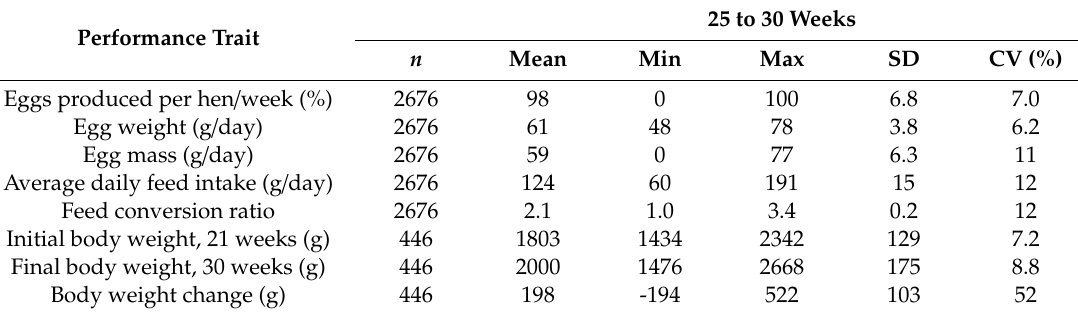
Table 1. Descriptive statistics of hen performance of 446 individually caged ISA Brown hens aged between 25 and 30 weeks old.